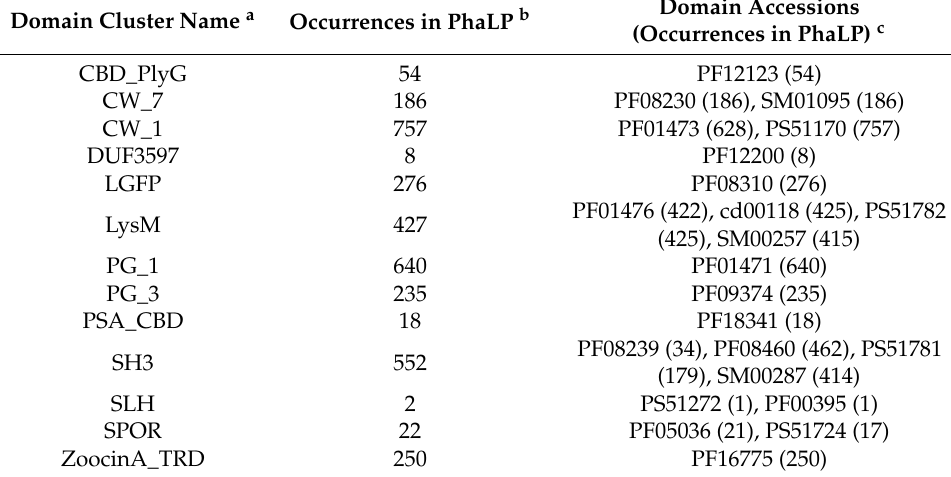
Table 2. CBD clusters observed in phage lytic proteins and their related domain accessions from various protein